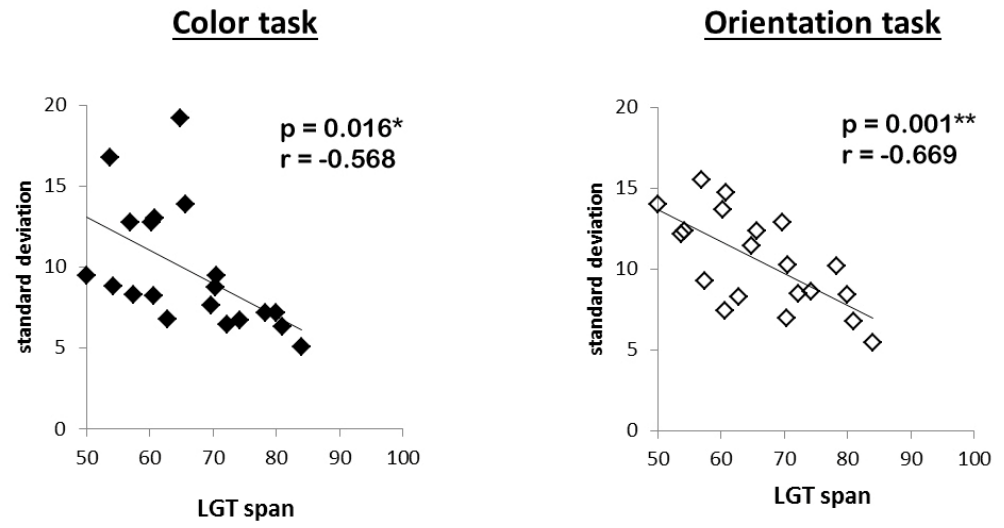
Figure 5. Statistical relations between working memory precision for color and orientation and working memory capacity (Lern und Gedächtnistest (LGT) performance). ∗ = p ≤ 0.05. ∗∗ = p ≤ 0.01.